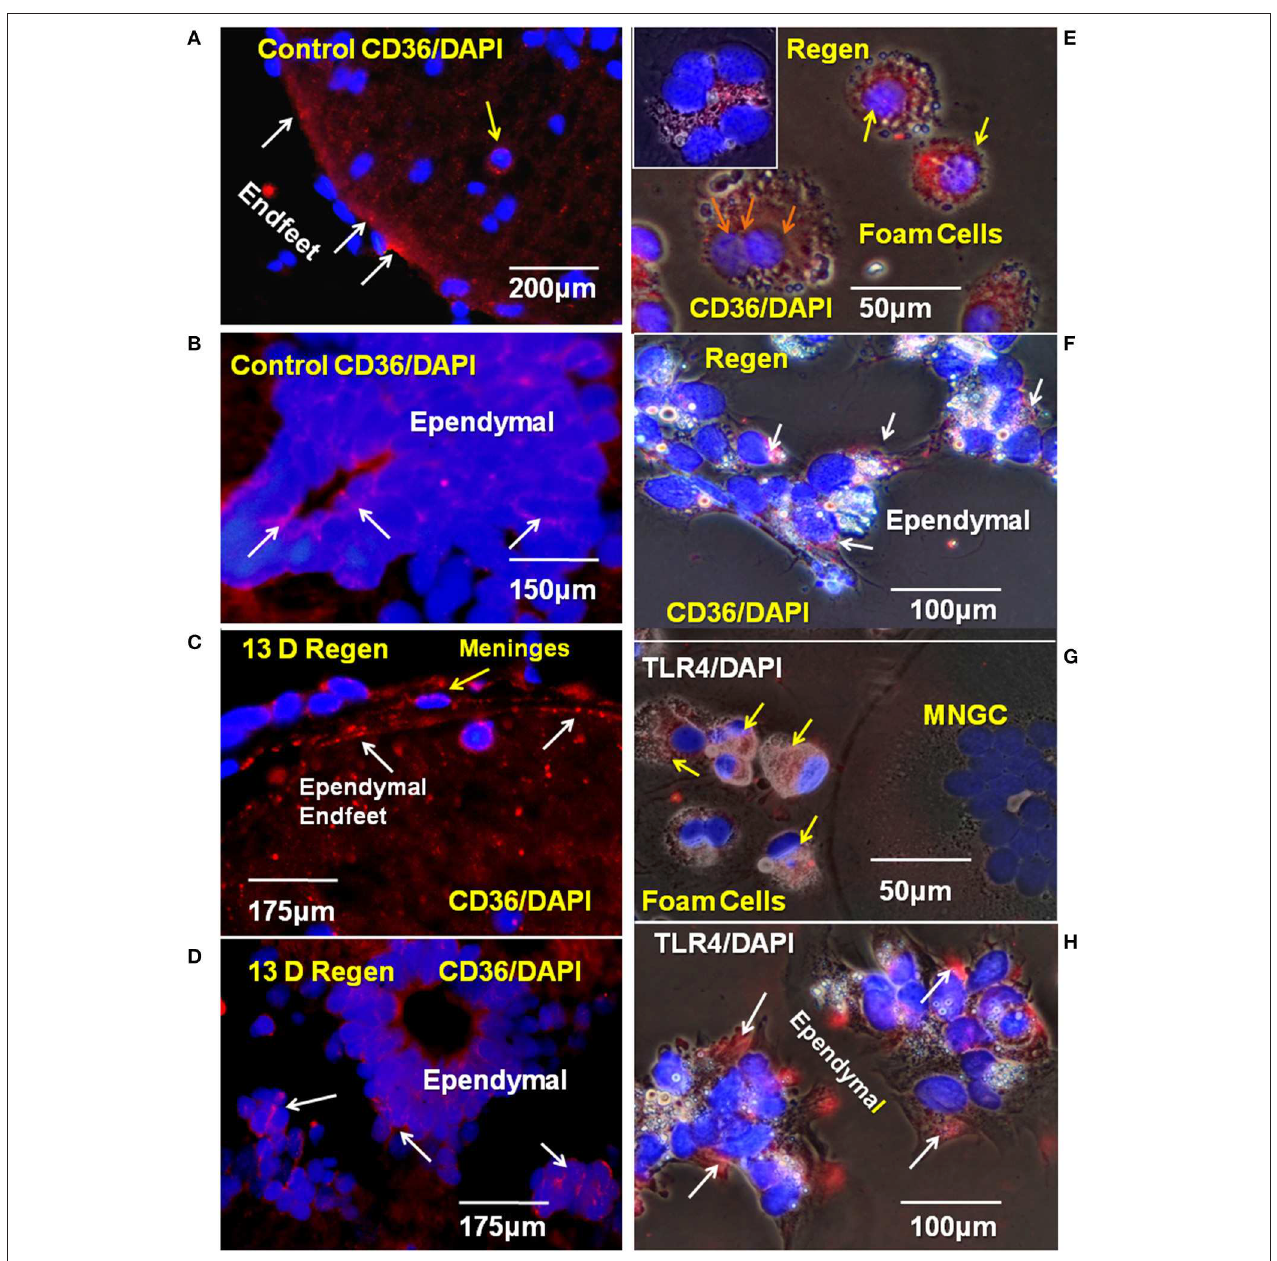
FIGURE 6 | CD36 and TLR4 in regenerating cord in vivo and in vitro . (A) The scavenger receptor CD36 was detected on the endfeet of ependymal cells in control cord paraffin cross-sections. Fluorescence image. (B) CD 36 is also present on ependymal cell bodies in intact adult Axolotl spinal cord. Fluorescence image. (C) In paraffin sections from regenerating cord stump CD36 was detected in ependymal endfeet in the reactive meninges. Fluorescence image. (D) CD36 also present on ependymal cell bodies in regenerating cord, proximal stump. Fluorescence image. (E) In vitro , CD36 is found on foamy macrophages from 10D regenerate spinal cords 6 days in vitro (yellow arrows). Orange arrows show three nuclei in CD36 + MNGC. Inset in (E) shows a CD36 + MNGC with six nuclei. (F) CD36 + Ependymal cells (white arrows) in explant cultures from a 10D regenerate spinal cord 6 days in vitro . (G) TLR4 was detected in foamy macrophages (yellow arrows) in culture on cells from 14 days regenenerates, 17 days in vitro . (H) Ependymal cells from 14 days regenenerates, 17 days in vitro are also TLR4 + (white arrows). D, day; Regen, regenerating; MNGC, multinucleated giant cells; TLR4, toll like receptor 4. Magnification bar is shown in the lower portion of each image.